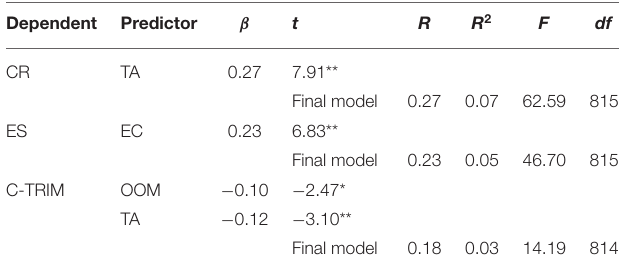
TABLE 7 | Hierarchical regressions predicting emotion regulation and unforgiveness. Dependent